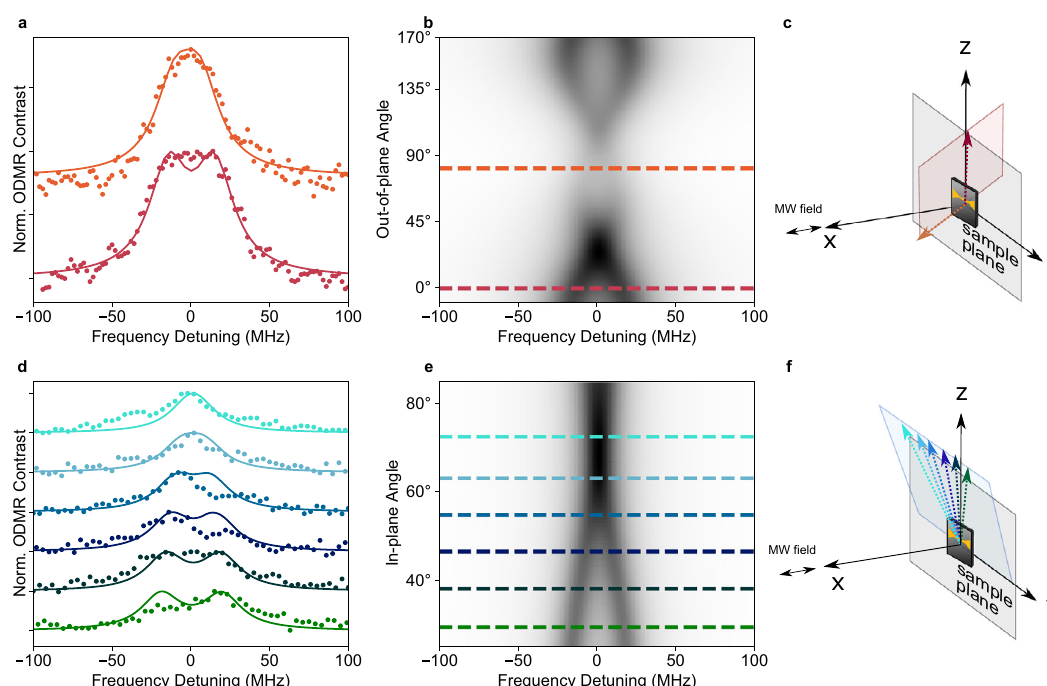
Fig. 5 Angular dependence of ODMR below saturation. a ODMR spectra (circles) for defect A at two magnetic fi eld orientations, along the z -axis (red) and in the x – y plane (orange), magnetic fi eld vectors represented in ( c ). The solid curves are fi ts to the data using a S = 1 model with D = 25 MHz, E = 5 MHz and the defect D tensor symmetry axis ( z ′ ) rotated in the plane of hBN. b The simulated ODMR contrast for defect A through the red plane shown in panel ( c ). The shaded area represents signal intensity normalised to 1. c Schematic showing the magnetic fi eld orientations (red and orange vectors) for measurements in ( a ) and ( b ). The red vector points along z , and the orange points out of the xy plane. d ODMR spectra (circles) for defect E at a series of magnetic fi eld orientations through a plane, shown in panel ( f ). The solid curves are the fi t the S = 1 model with D = 25 MHz, E = 5 MHz and z ′ rotated in the hBN plane ( e ) The simulated ODMR contrast for defect E through the blue plane shown in panel ( f ). f Schematic showing the magnetic fi eld orientations (blue vectors) for measurements in ( d ) and ( e ). The blue vectors point at different angles in zy plane with a projection onto x . The sample orientation is shown in both ( c ) and ( f ) but the cartoon image (in zy